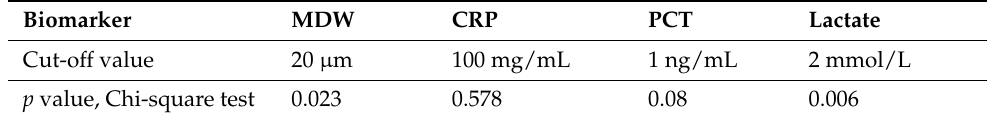
Table 2. Chi-square test for MDW, CRP, PCT, and lactate. Biomarker MDW CRP PCT Cut-off value p value, Chi-square